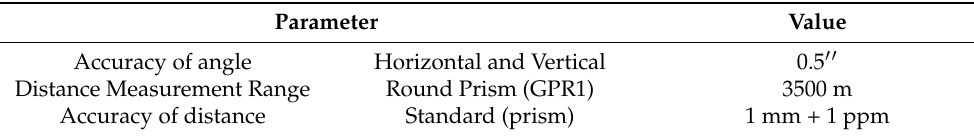
Table 3. Parameters of Leica TS30 total station